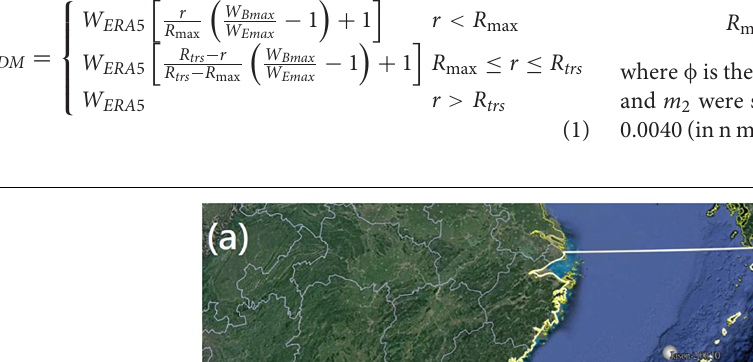
Frontiers in Marine Science |